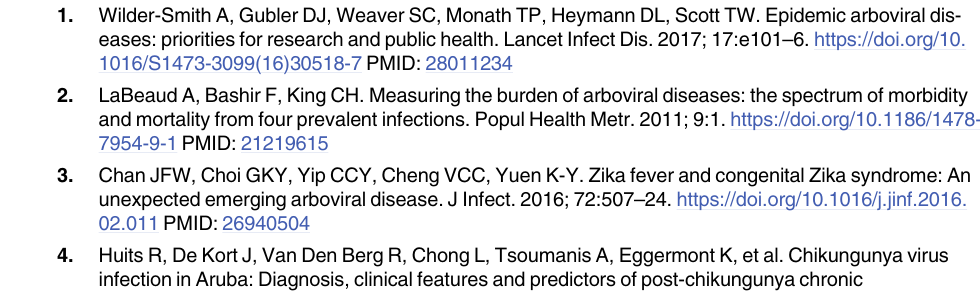
S1 Table. Listing of all included research articles. S2 Table. Listing of all included surveillance reports. S3 Table. Multi-way table showing CHIKV DALY range calculations. CHIKV, chikungunya virus; DALY, disability-adjusted life year. S4 Table. Multi-way table showing CHIKV DALY discrete calculations. CHIKV, chikungu- nya virus; DALY, disability-adjusted life year. S5 Table. Multi-way table showing ZIKV DALY range calculations. DALY, disability- adjusted life year; ZIKV, Zika virus. S6 Table. Multi-way table showing ZIKV DALY discrete calculations. DALY, disability- adjusted life year; ZIKV, Zika